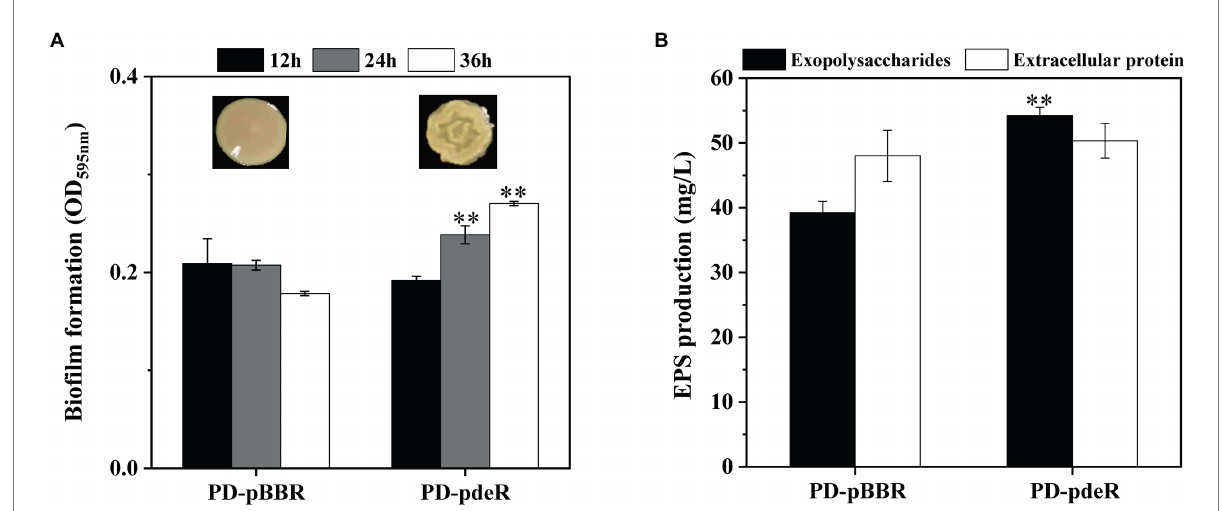
FIGURE 2 (A) The colony morphology and the biofilm formation of PD-pBBR (left) and PD-pdeR (right) strains after 12, 24 and 36 h incubation, respectively. (B) The exopolysaccharides and extracellular protein production of PD-pBBR and PD-pdeR after 36 h incubation. Data are presented as mean ± SD, n = 3. ** p < 0.01 compared with the control strain